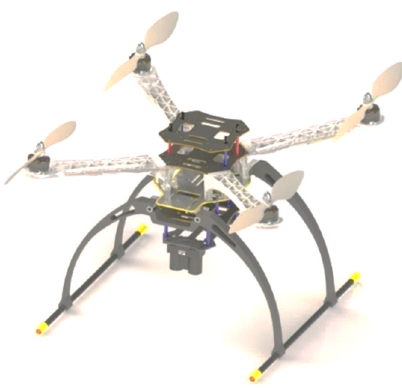
Figure 1. 3D CAD design of the external structure of an aerial vehicle with a camera mounted on it.